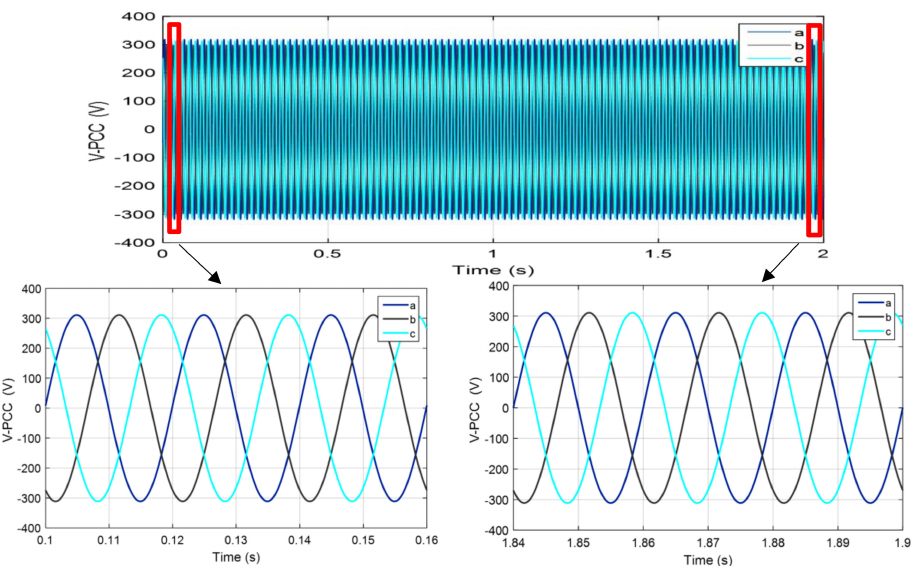
Figure 10. Three-phase voltages at PCC after compensation with proposed control